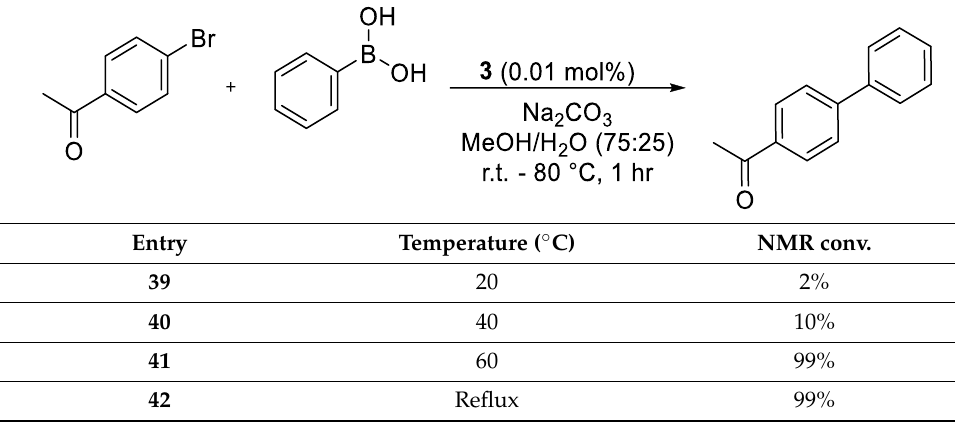
Table 5. Temperature and NMR conversion obtained from the temperature